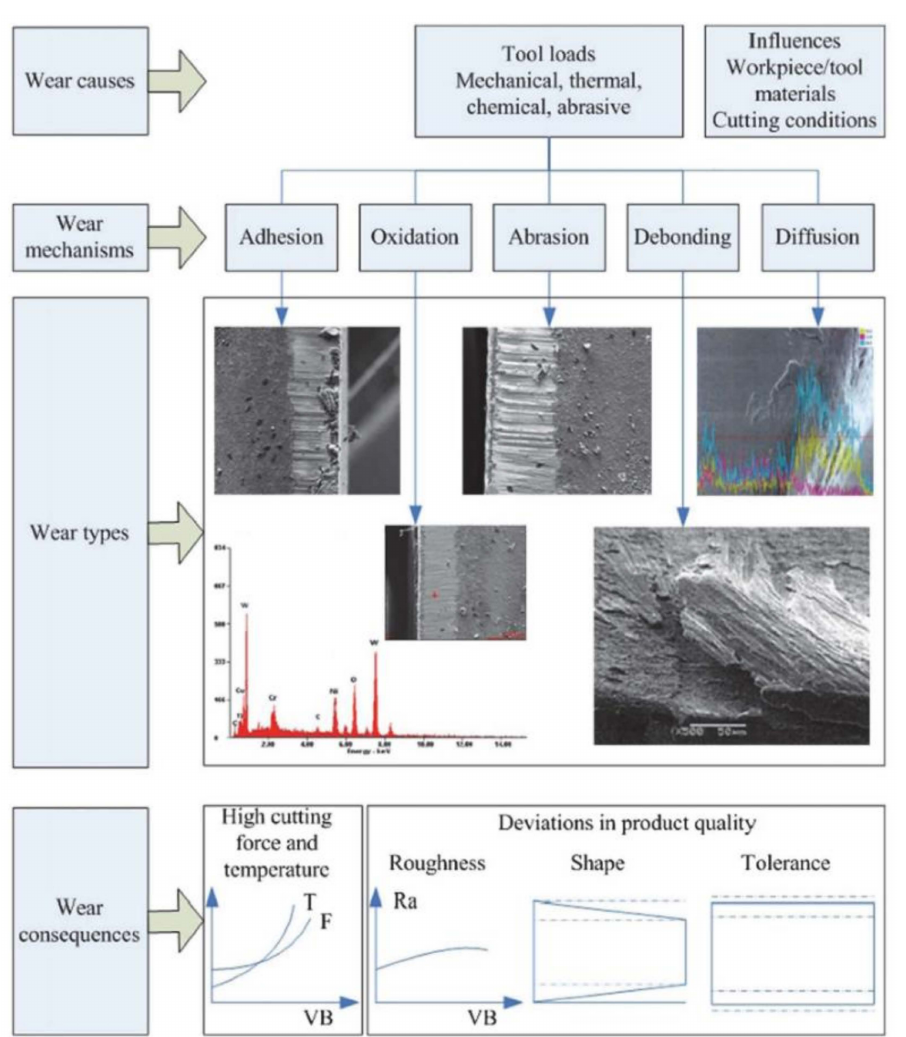
Figure 14. The wear causes, wear mechanisms, wear types, and wear consequences in the cutting of Ni-based superalloys [118].